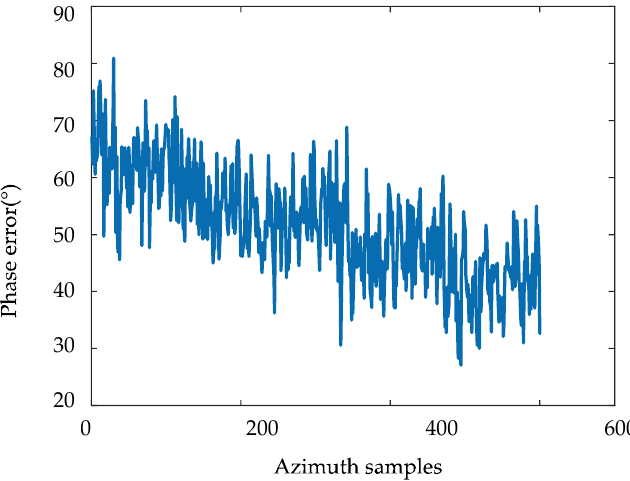
Figure 10. Two-channel data extraction diagram.